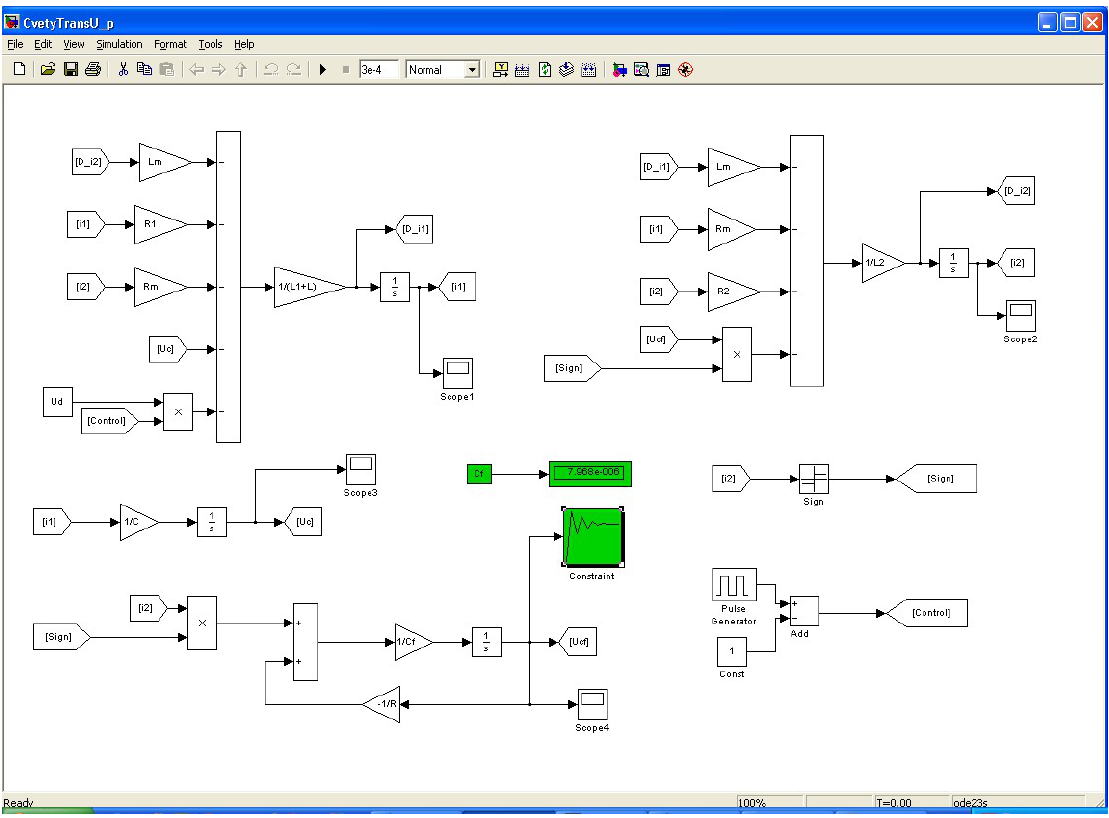
Figure 18. Block diagram of the converter model and the embedded Simulink Response Optimization tool.